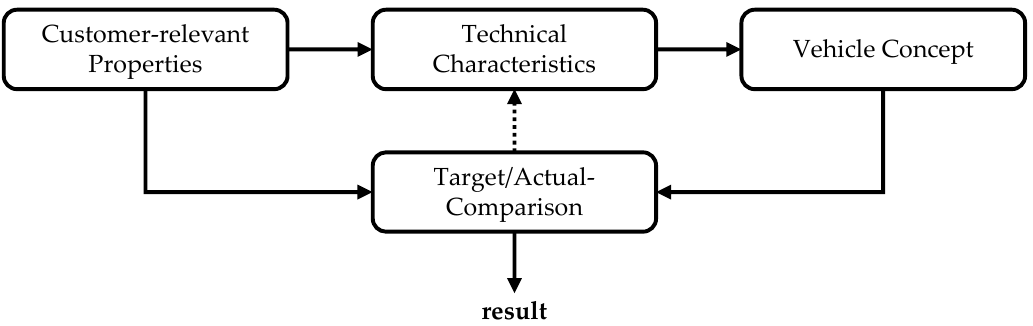
Figure 1. Vehicle concept development process, adapted from [4,5].